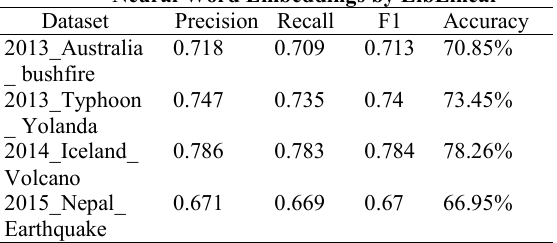
Table 4. Classification Results using Standard Bag of